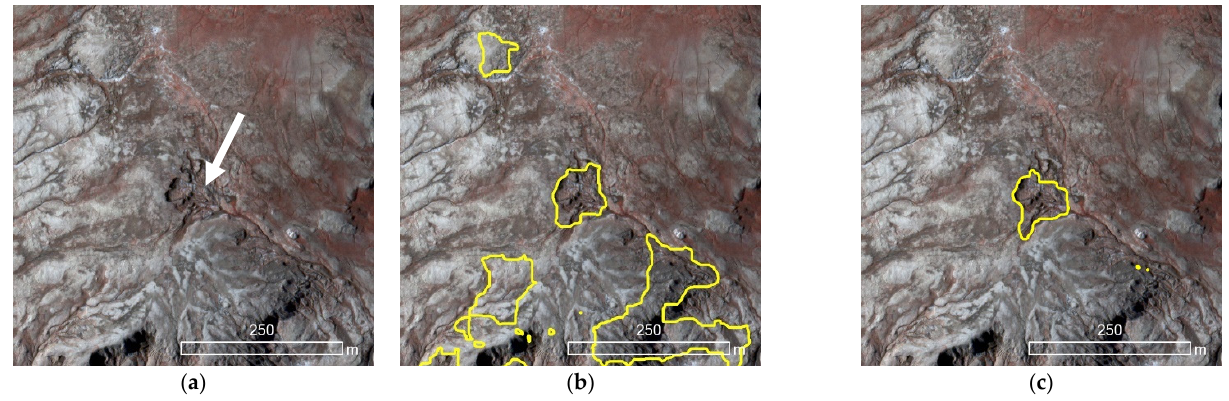
Figure 22. Example zoomed-in views showing model transferability across study sites. ( a ) Original image from Ellesmere Island. ( b ) The DLCNN model trained on Banks Island’s RTS samples and applied to the Eureka Sound Lowlands. ( c ) The DLCNN model trained on combined RTS samples and applied to Eureka Sound Lowlands. White arrows indicate the location of RTS. Underlying imagery is at 0.5 m resolution as false color composites.